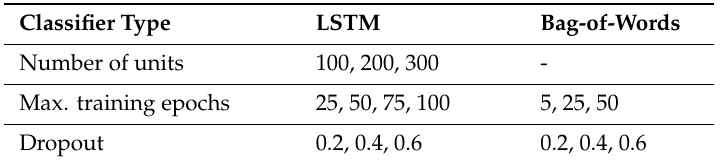
Table 4. List of all of the parameters tested for the text classification